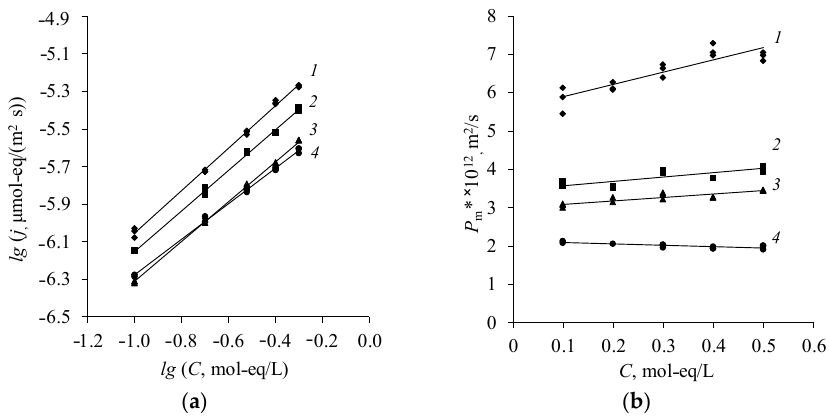
Figure 6. Concentration dependence of the diffusion flux in bilogarithmic coordinates ( a ) and the differential coefficient of diffusion permeability ( b ) of diethylammonium sulfate of various types of anion-exchange membranes. 1 — МА -40L, 2 — МА -41, 3 —Ralex AMH, 4 — МА -40.